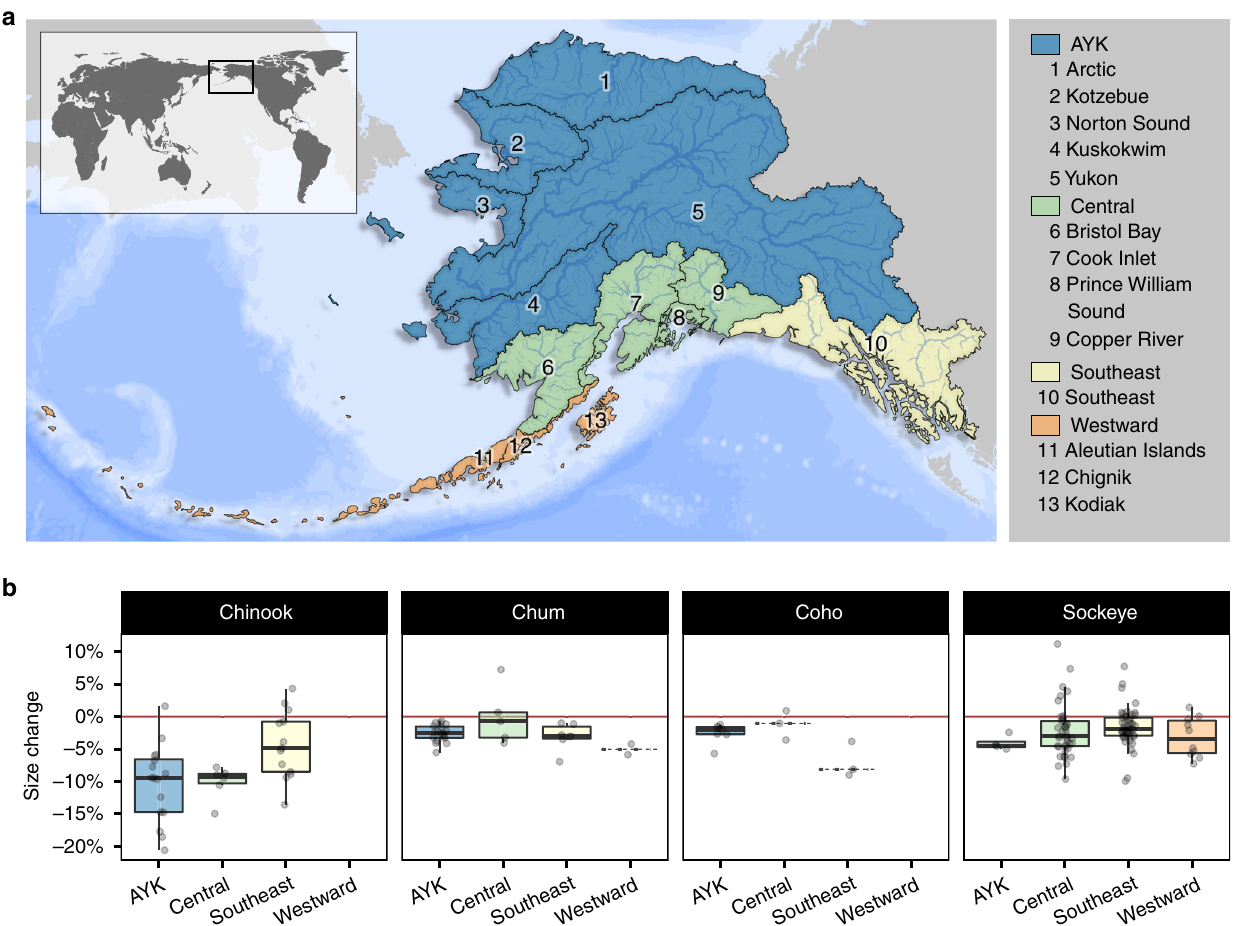
Fig. 1 Across Alaska, average salmon body size has gotten smaller. On average, salmon body size was smaller post-2010 compared with pre-1990 across all areas and species examined. a Map of sampling area with regions numbered and colored by Alaska Department of Fish and Game management area. Our analyses included data from all regions shown except Arctic. b Boxplots show percent change in mean length between data collected before 1990 and after 2010. Points show change in mean length for individual populations. Red line indicates no change. Center line represents the median, box limits represent the upper and lower quantiles, whiskers represent the 1.5× interquartile range. Only populations for which we had data in both periods were included (100 sockeye, 34 Chinook, 32 chum, and 13 coho salmon populations). If suf fi cient data were available for three or fewer populations, the box was replaced by a gray dashed line at the median. AYK represents the Arctic – Yukon – Kuskokwim management area. Sample sizes are presented in Supplementary Data